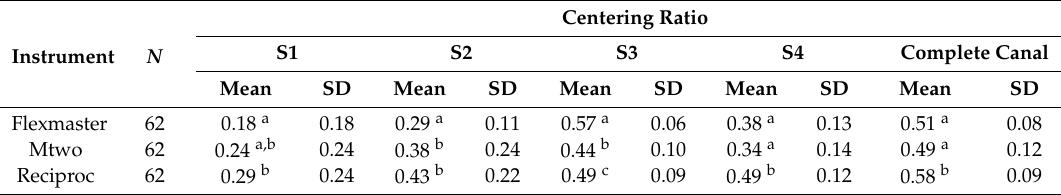
Table 1. Mean centering ratios and SDs of the different systems at different canal sections (S1: apical, S4: coronal) and of the complete canal (ratio of 1.0 =